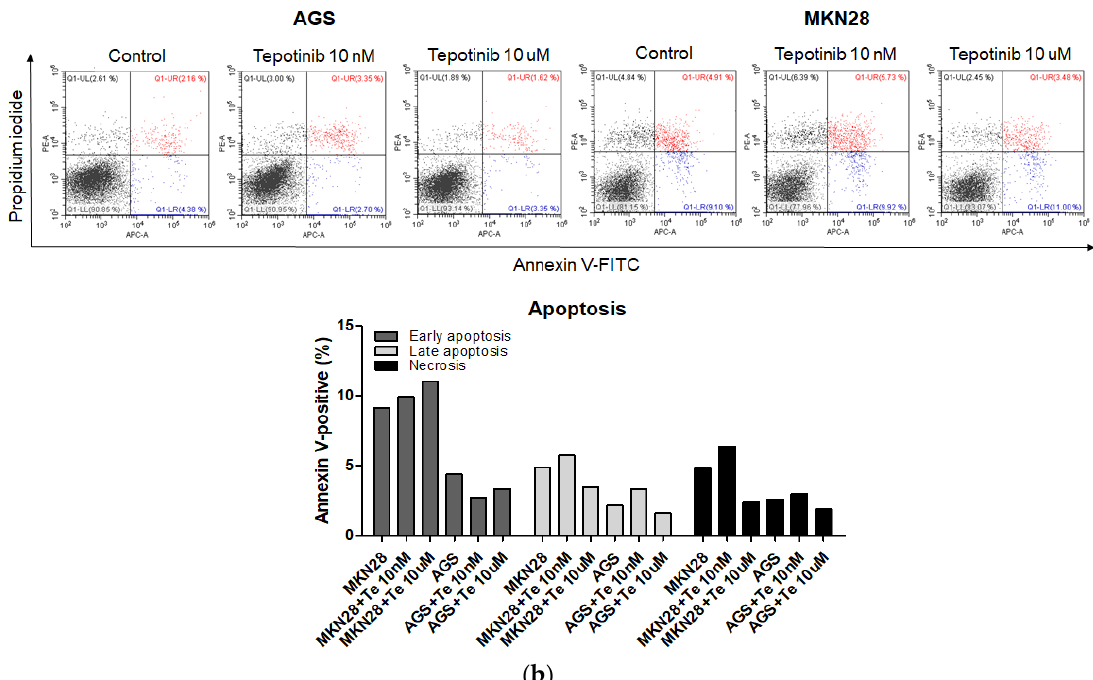
Figure 3. Apoptotic activation of c-MET-positive ( a ): MKN45, SNU620, and KATO III and c-MET-negative ( b ): AGS and MKN28 GC cells induced by tepotinib. Flow cytometric assay of the apoptotic and necrotic cells (UL: necrotic; UR: late apoptotic; LL: live; LR: early apoptotic) after 48 h of incubation with tepotinib (10 nM).